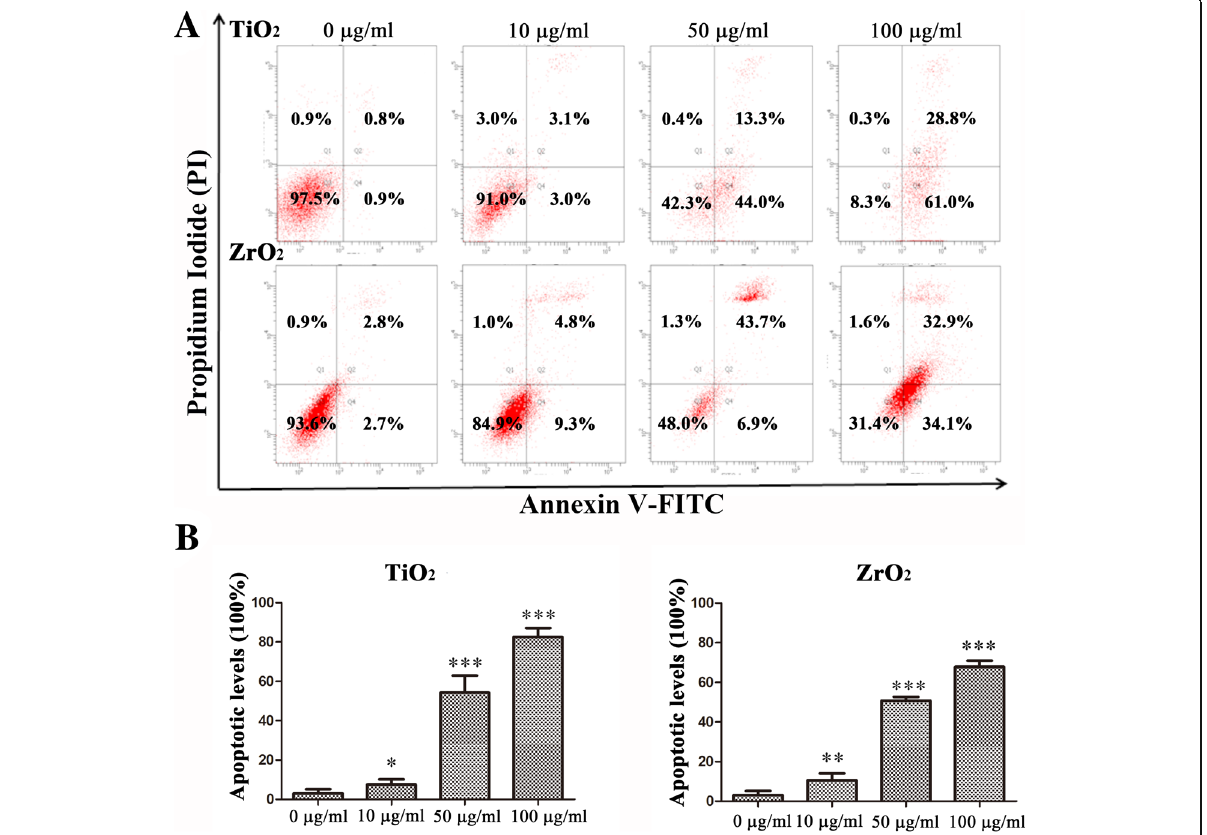
Fig. 4 TiO 2 and ZrO 2 NP-induced apoptosis in 3T3-E1 cells. a After the 3T3-E1 cells were treated with the TiO 2 and ZrO 2 NPs at various concentrations for 48 h, the levels of cell apoptosis were detected. b The apoptotic levels including early apoptosis and late apoptosis levels were calculated,